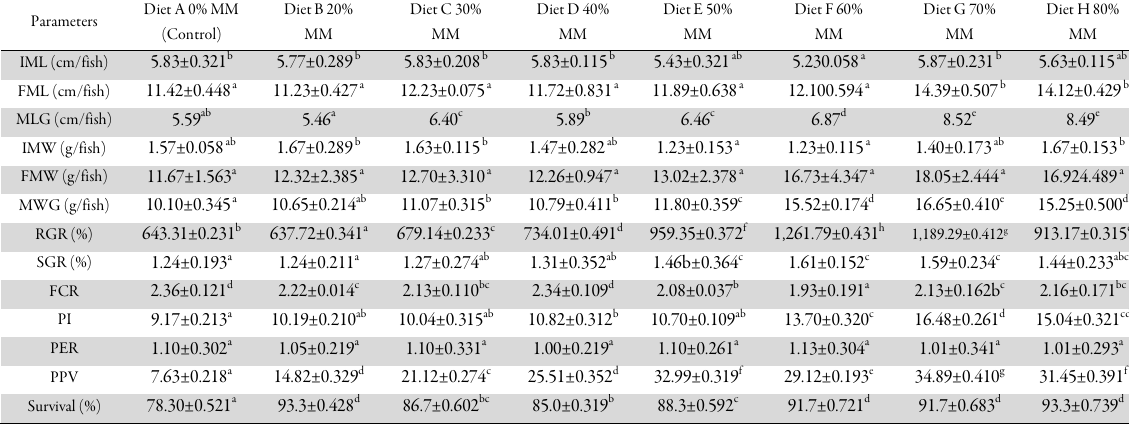
Table 4. Growth and nutrient utilization of Clarias gariepinus fed with various diets Parameters